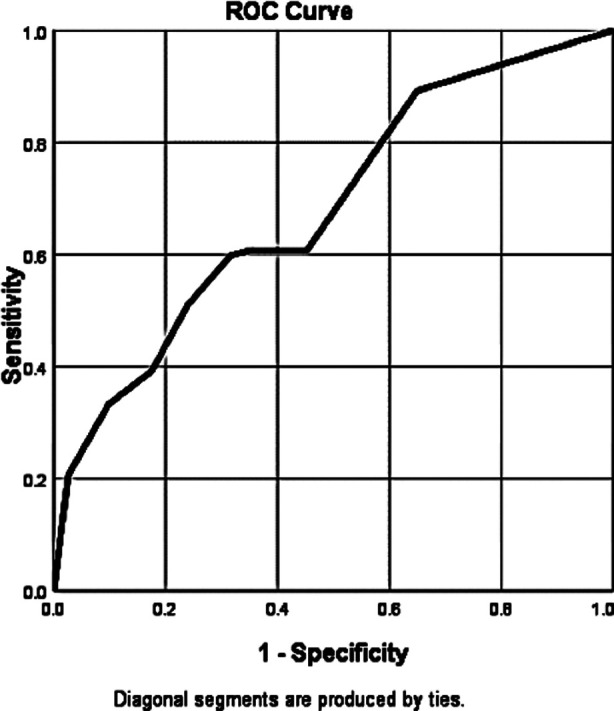
ROC Plot of MEWS Score for Mortality.